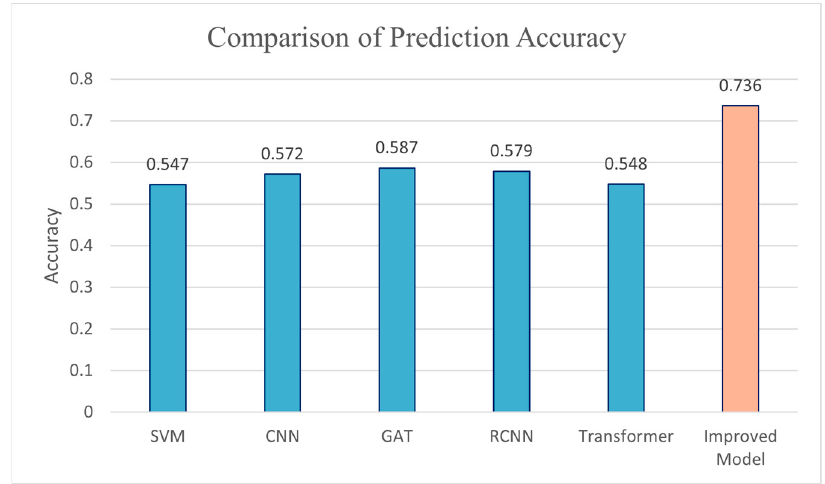
Figure 6. Comparison of prediction model e ff ects.